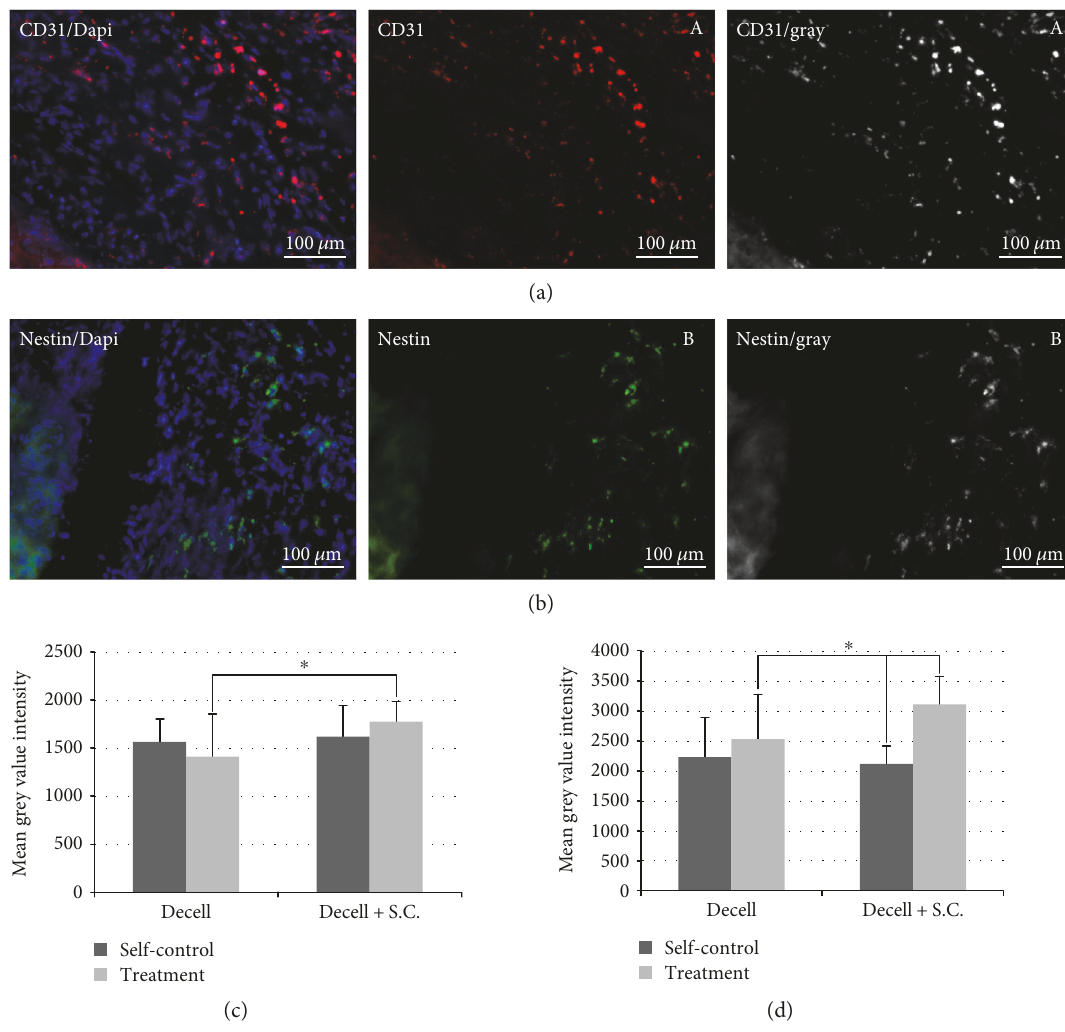
Figure 9: Immunohistochemical analysis of the regrowth tissues within the rat diaphragm. (a) CD31 positive cells (red) represent the vascularity that can be detected within the repaired rat diaphragmatic tissue. (b) Nerve regeneration can be evaluated by Nestin staining (green) within the implanted ECM sca ff olds. We also measured the expression level of CD31 (A) and Nestin (B) through quantities of their gray fl uorescence. The measurements indicated the revascularization (c) and reinnervation (d) that occurred in the repaired defect. ∗ p < 0 05